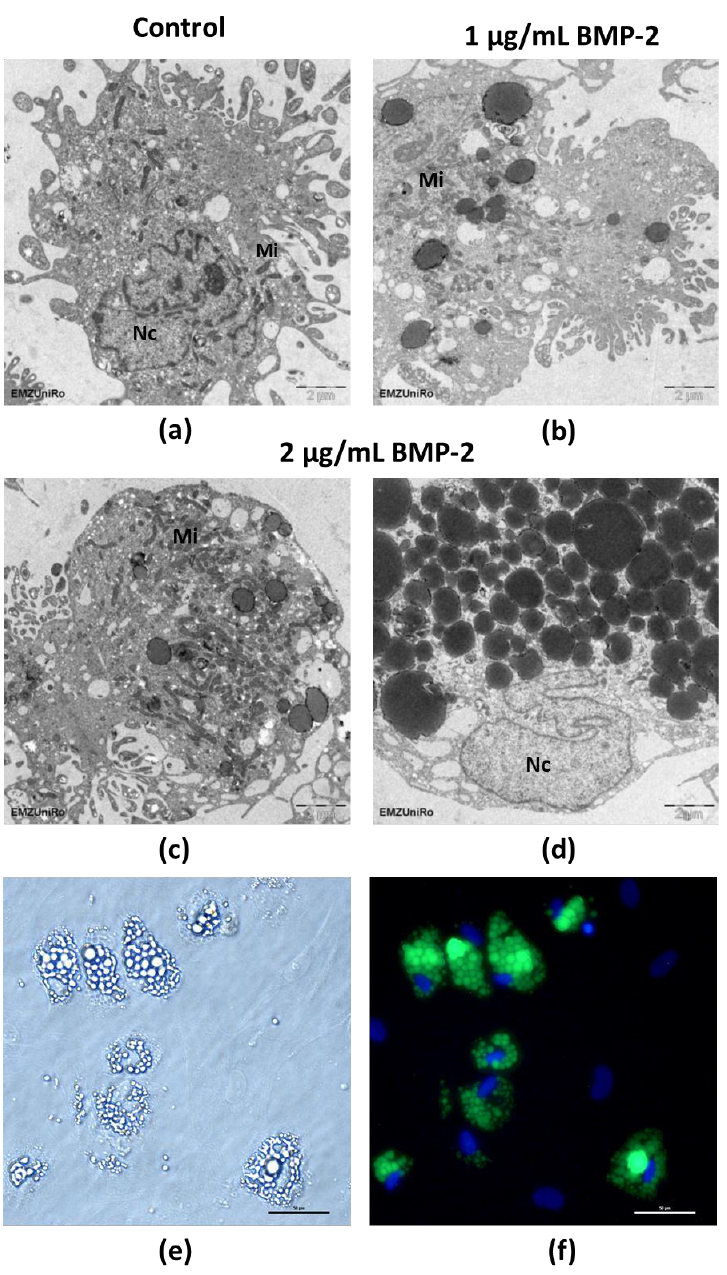
Figure 5. Cell morphological characterization of pre-osteoblasts stimulated with 1 and 2 µg/mL BMP-2 for up to 28 days. ( a – d ): Transmission electron microscopy images. After BMP-2 exposure,